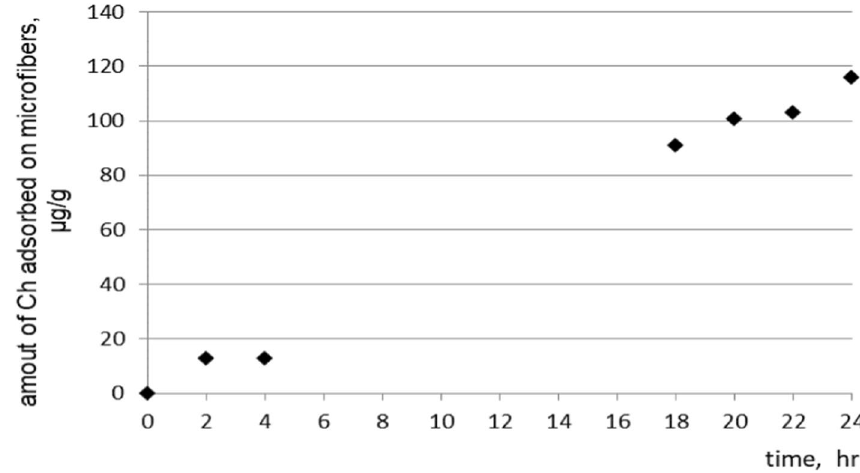
Fig. 2 Chrysene (μg/g) adsorbed on microfibers as a function of